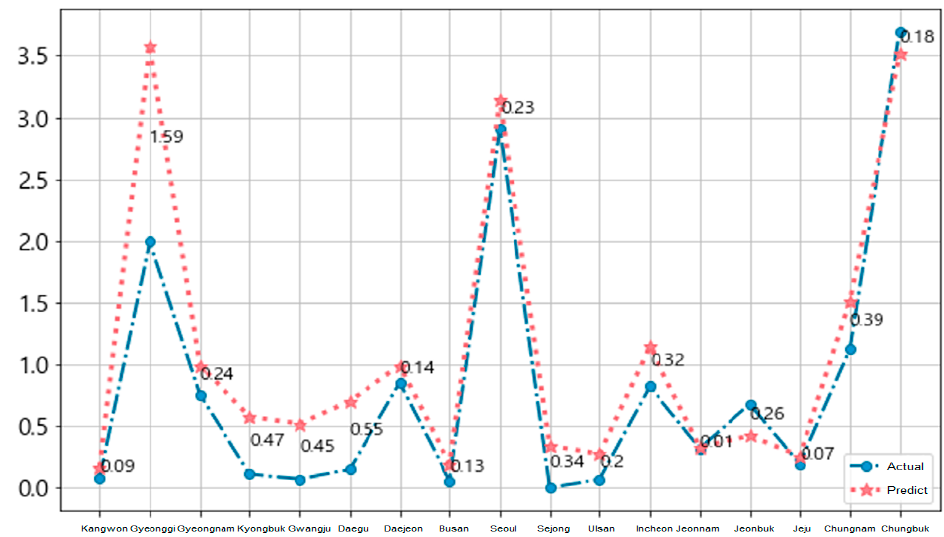
Figure 11. National prediction of epidemic of hepatitis A per local government unit.